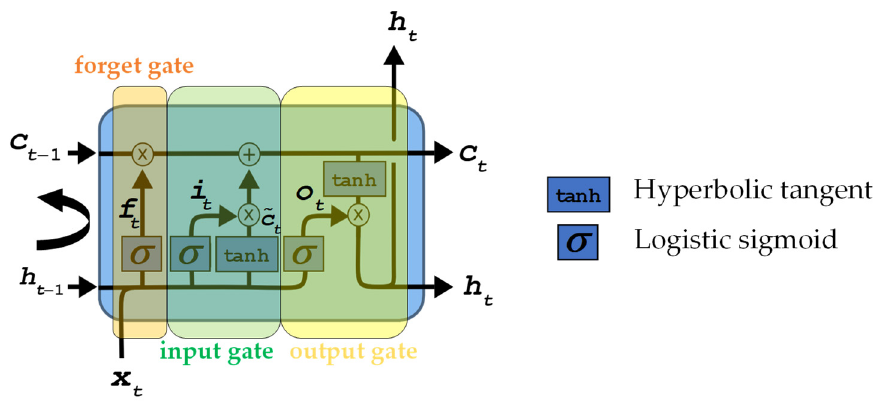
Figure 5. Control gates of a simple LSTM cell (vanilla LSTM).